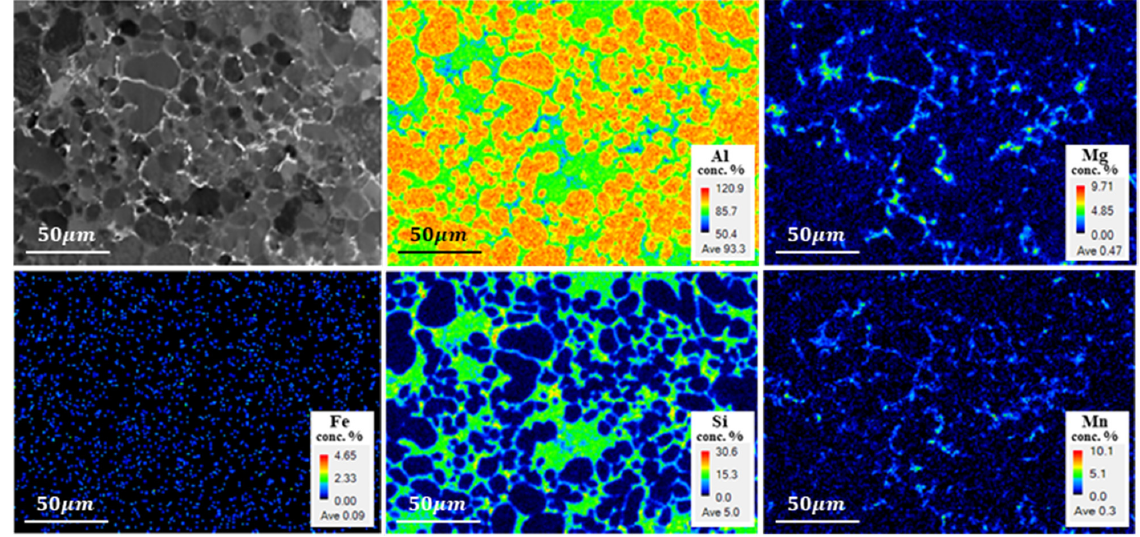
Figure 2. EPMA micrograph and chemical element distribution maps of crept AA365 alloy at 373 K: Al, Mg, Fe, Si, Mn .